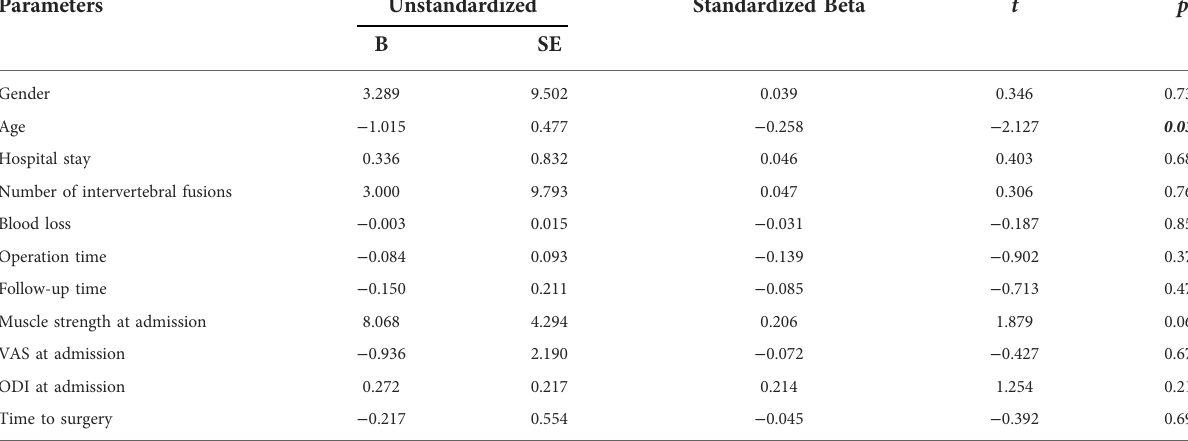
TABLE 4 Multivariate regression analysis regarding muscle strength improvement rate.